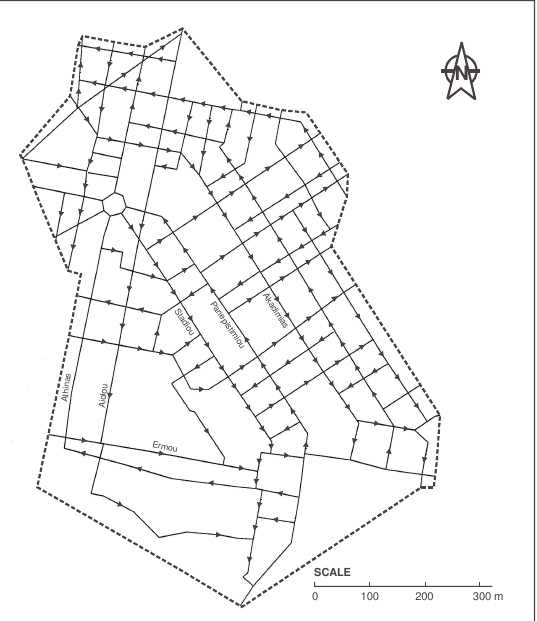
Figure 1. Graphical representation of the inner road network of Athens used in the study The effect of the frequency, in which the routing information is updated, is investigated by assuming control intervals of different duration, such as those of 900 sec, 300 sec, 60 sec and 30 sec. The results of the GEH error statistics indicate that the estimated (at the first stage) and the predicted (at the third stage) traffic flows reproduce without statistically significant differences the actual and the simulated (produced by the DNA model) traffic flows respectively (Figure 2). More specifically, in all cases considered, the assignment of the estimated O-D matrix and, particularly, of the predicted O-D matrices onto the network produces link traffic flows at observed links with GEH < 5 at a percentage equal or higher than 85% over the whole study period T . The fact that the above acceptance criterion is satisfied for each specific count interval t only in the case of using shorter control intervals p ( £ 300 sec) signifies that such intervals can lead to a more accurate prediction of the network traffic conditions, in comparison to longer control intervals, such as that of 900